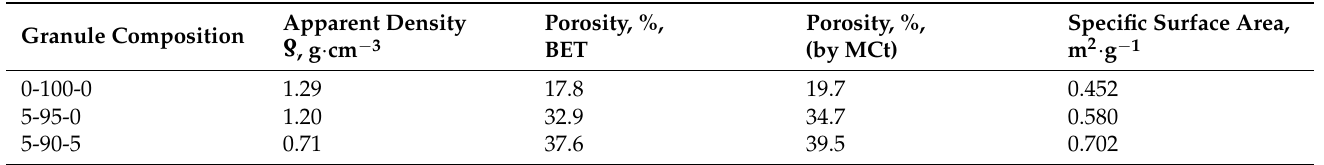
Table 5. Apparent density, porosity, and specific surface area of biocomposite granules of different compositions.